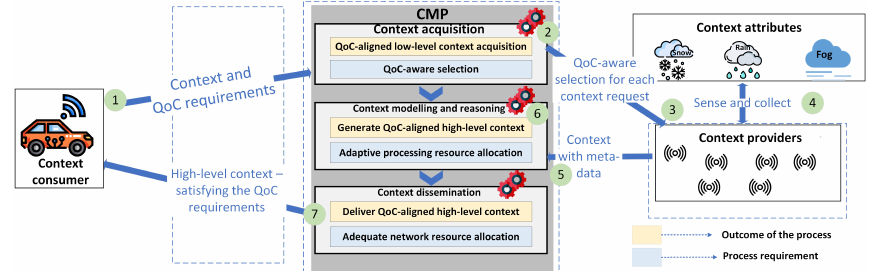
Figure 2. Motivating scenario—the data flow that occurs at each context actor upon enabling the end-to-end QoC-awareness in a context-aware IoT environment. Numbers indicate the order of data flow in such